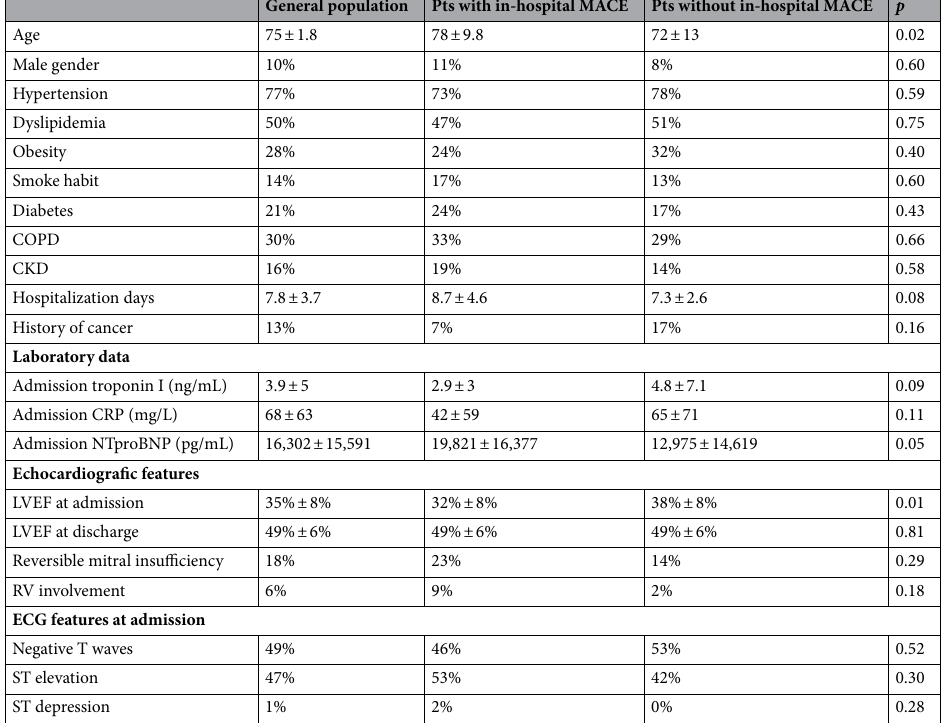
Table 1. Baseline features of patients with versus without events. CKD chronic kidney disease, COPD chronic obstructive pulmonary disease, ERS erythrocyte sedimentation rate, CRP C-reactive protein, LVEF left ventricular ejection fraction, MACE mayor cardiac adverse event, RV right